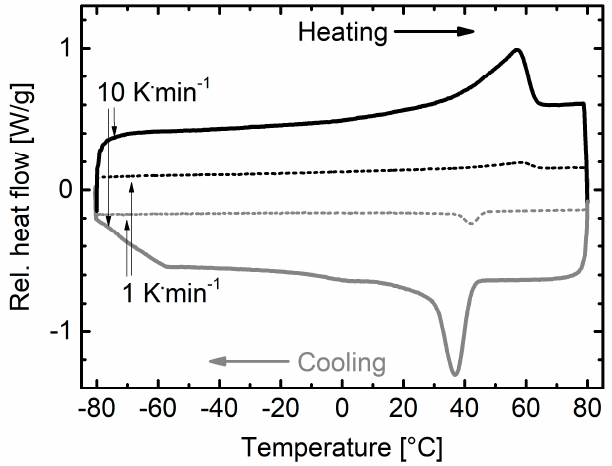
Figure 4. DSC thermogram of PEUU foam during second and third heating and cooling: Influence of the cooling and heating rate (10 K·min − 1 and 1 K·min − 1 ) on the phase transitions of PDA and PBA.